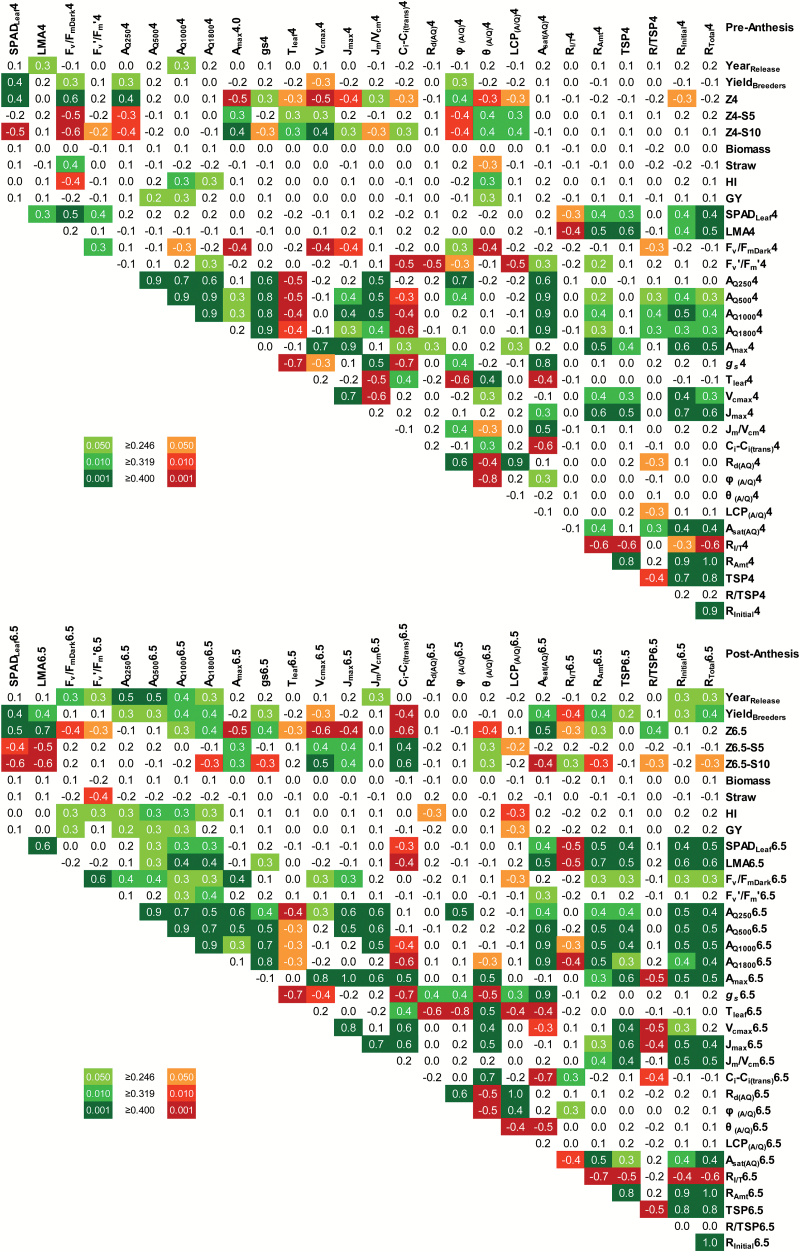
Correlation matrix showing the significance of linear correlations between paired mean values of photosynthetic and yield traits from 64 field-grown wheat cultivars. Numbers are Pearson product–moment correlation coefficients (r, df=62) and increasingly significant correlations (P≤0.05, P≤0.01, and P≤0.001) are indicated by increasingly darker shading. Year of cultivar release and yield data over multiple sites and years (YieldBreeders) were kindly supplied by the authors of a previous study (Clarke et al., 2012). Measured traits are described in Table 1. (This figure is available in colour at JXB online.)